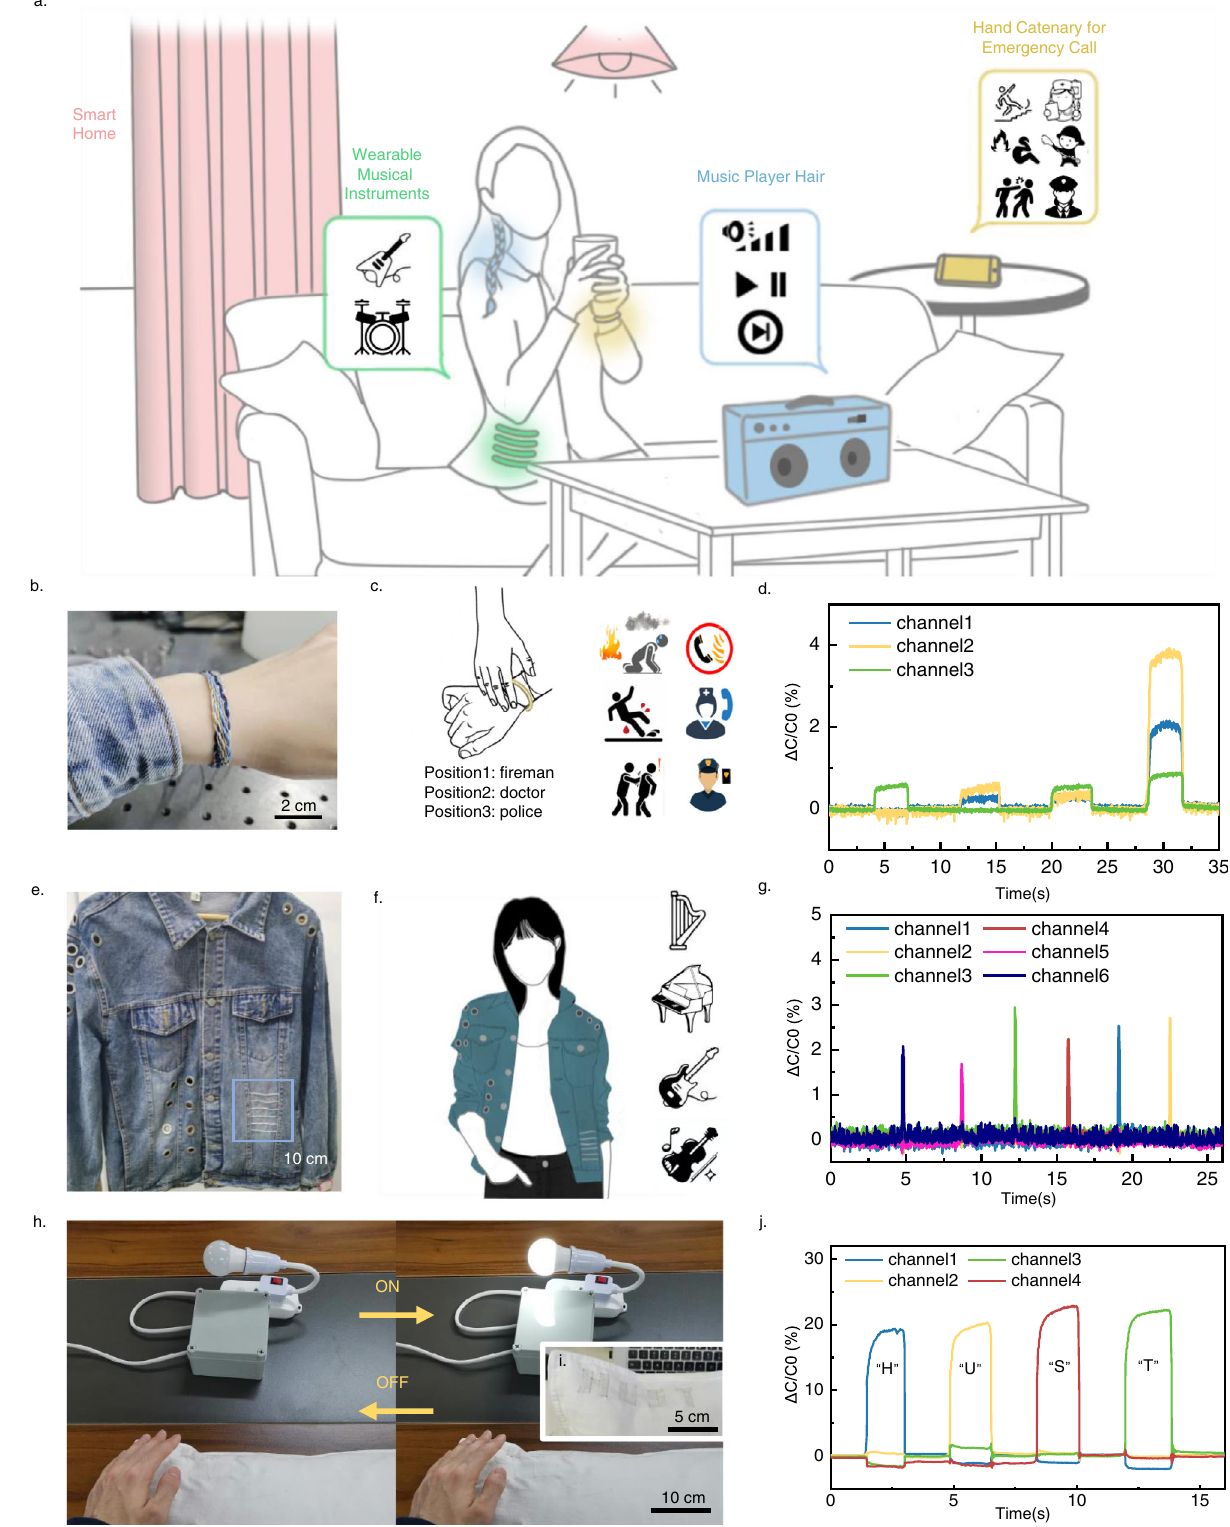
f Examples of smart fabrics for musical instruments playing. g Capacitance response for different interactive activities to the strings. h The light can be con- trolled by pressing interactive embroidery pillow based on core-spun yarns. i Photograph of interactive embroidery pillow based on core-spun yarns. j Capacitance response of pressing at different letter